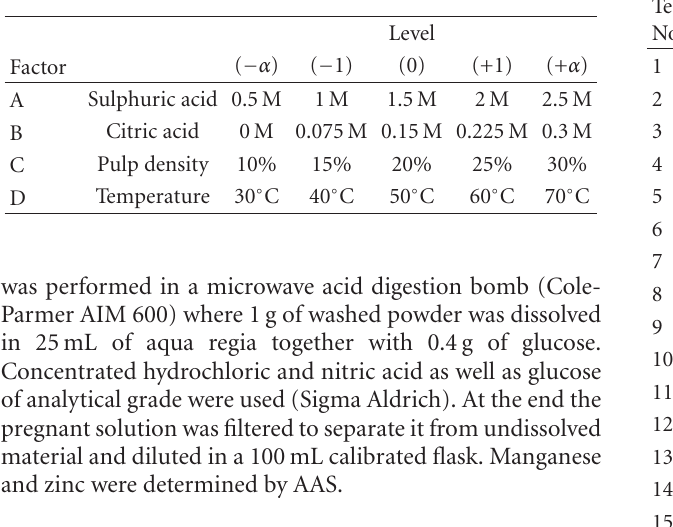
Table 3: List of tests of the second leaching